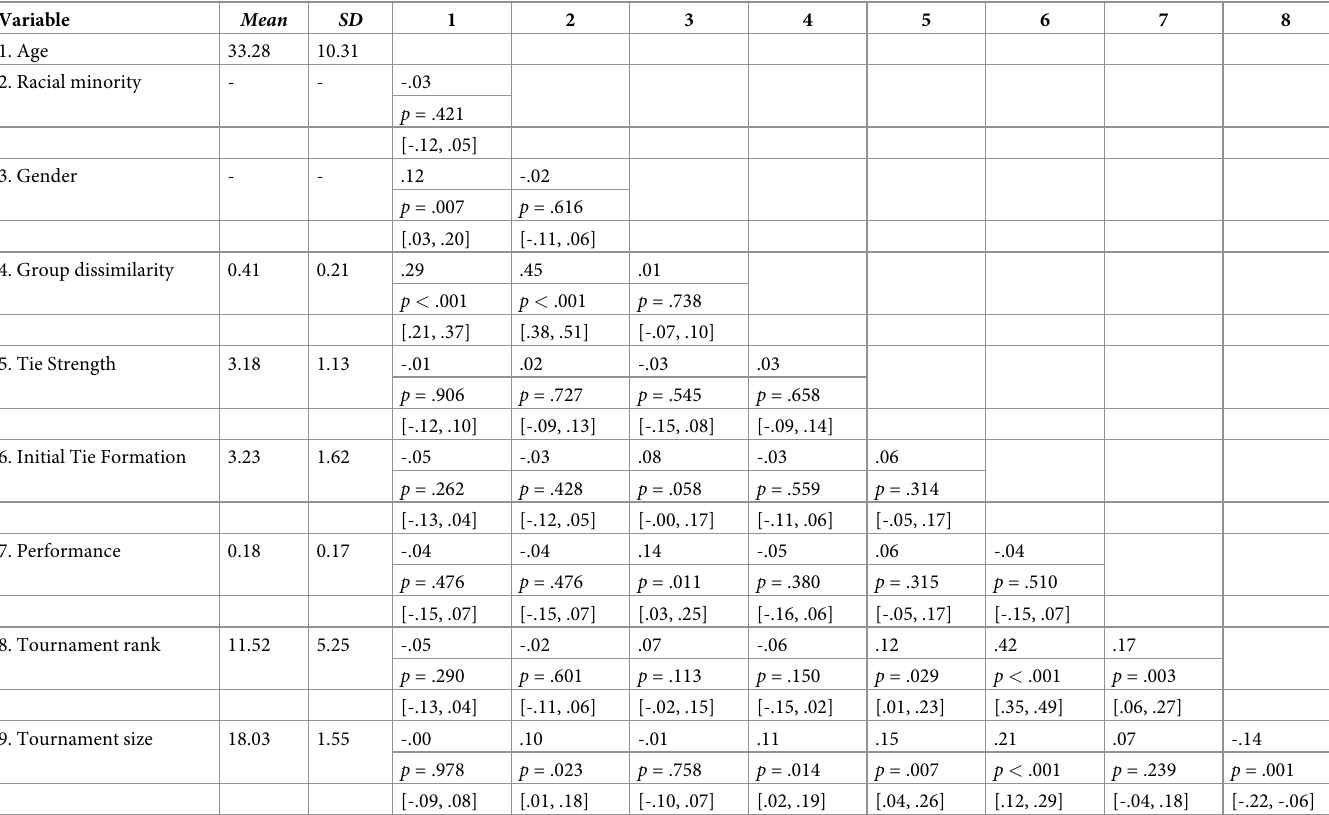
Table 1. Means, standard deviations, and correlations with confidence intervals.